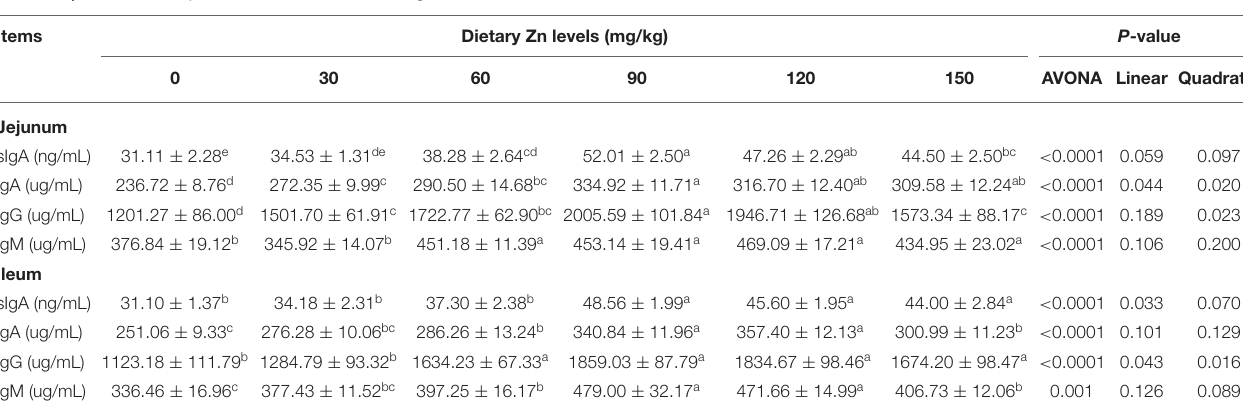
TABLE 7 | Effect of dietary Zn-Met on intestinal immunoglobulin content in